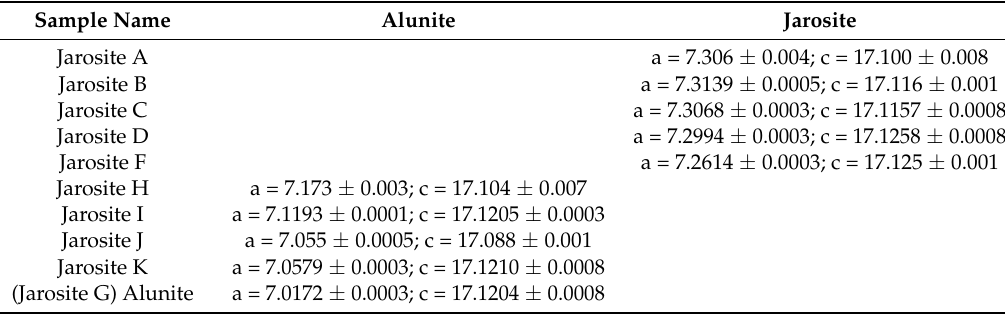
Table 3. Rietveld refinement for samples prepared in this study *.